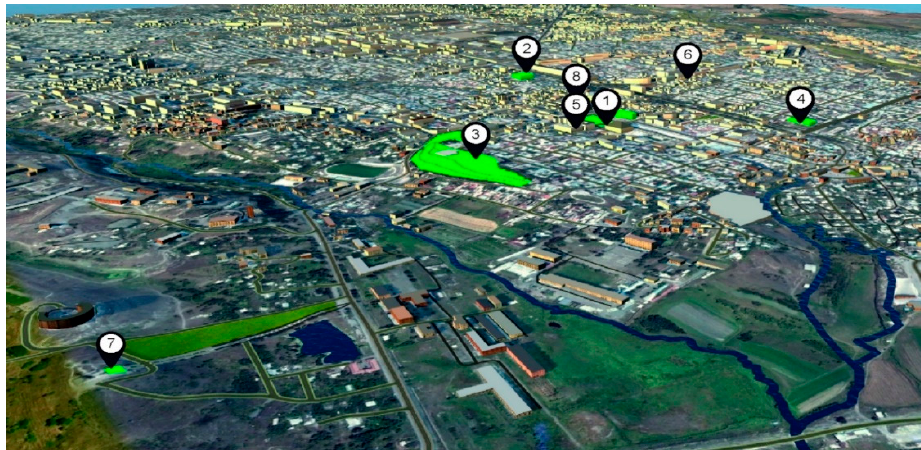
Figure 4. Visual model of Gyumri with indication of places and spaces where young people gather.